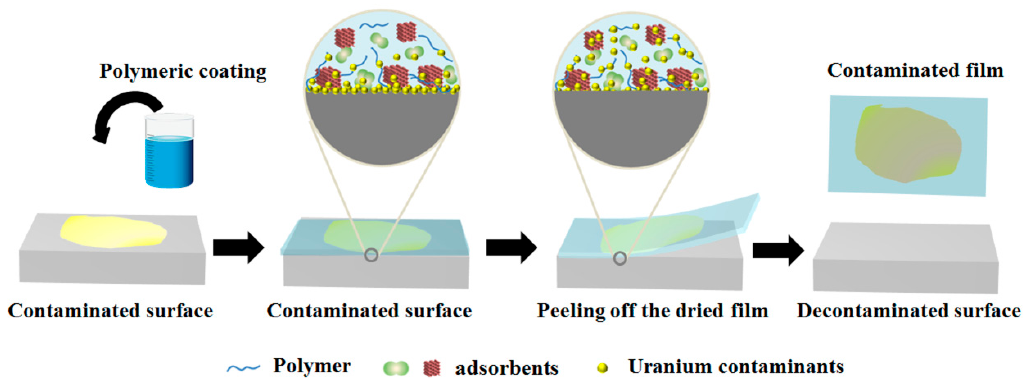
Figure 1. Schematic illustration of the decontamination process of polymeric coating.